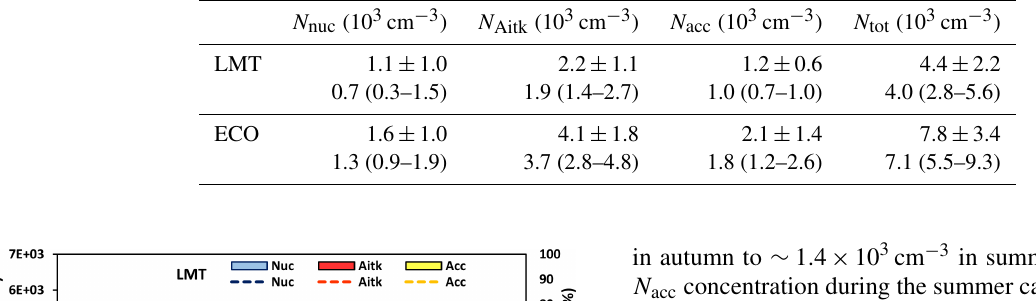
Table 2. Arithmetic means ± 1 standard deviation and median (25th–75th) percentiles of total, accumulation, Aitken, and nucleation PNC (cm − 3 ) for both sites.